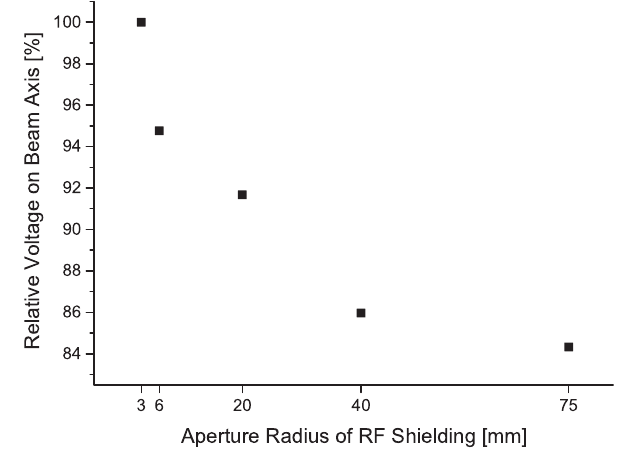
22. Comparison of the relative voltage on axis when the aperture of the rf shielding is opened. The reference voltage is the value for the 3 mm aperture radius which has been set to